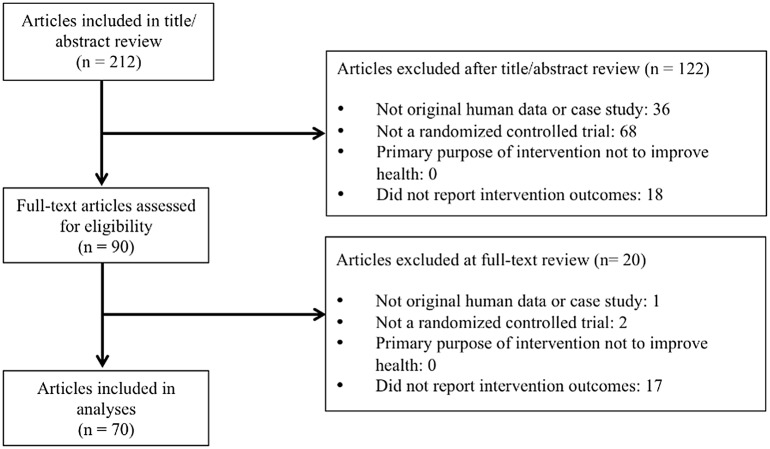
Article Selection.